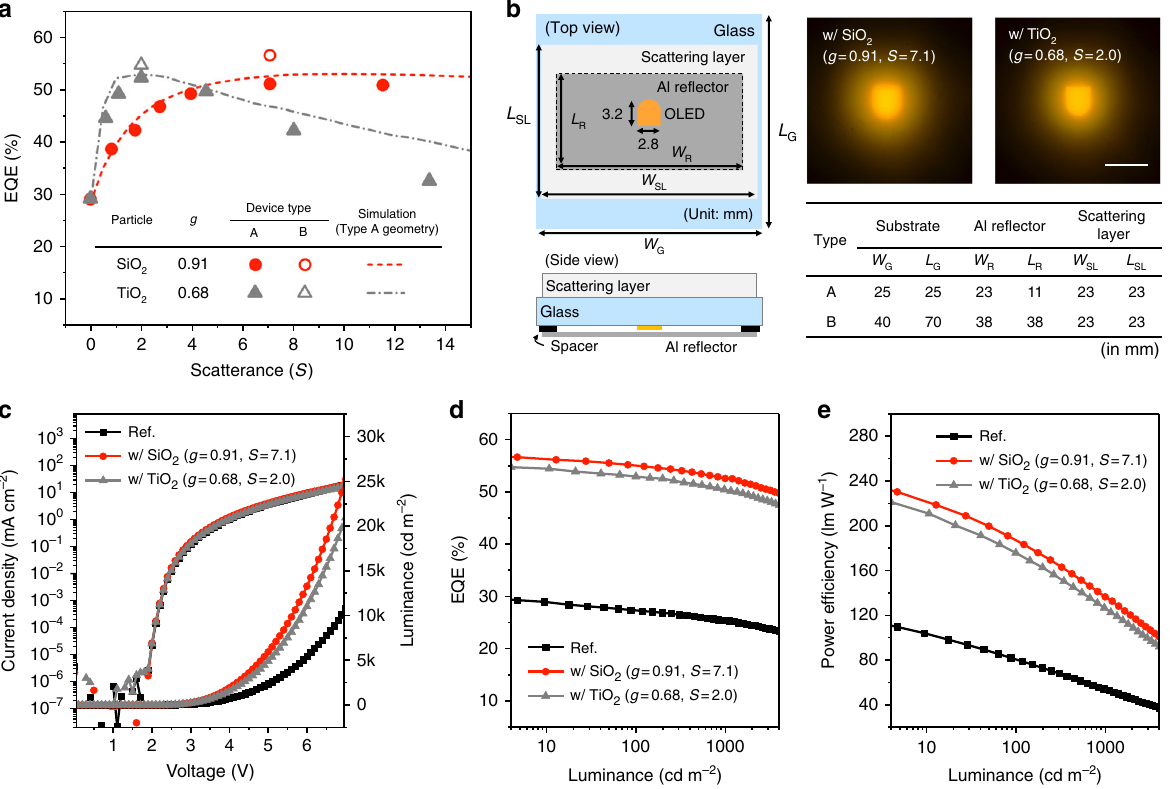
Fig. 4 The performance of organic light-emitting diodes (OLEDs) fabricated on large substrates. a The measured external quantum ef fi ciencies (EQEs) vs. scatterance ( S ) of OLEDs with SiO 2 -based (asymmetry parameter ( g ) = 0.91) and TiO 2 -based ( g = 0.68) scattering layers. The color-matched dotted lines indicate LightTools simulation results that re fl ect the actual geometry (Type A) used for EQE- S trend study. b Device test structures used to mimic a large- area device with a small, lab-scale active area. Type A uses a small substrate so that one can make several samples at the same time for studying the overall trend over certain variables. Type B uses a large substrate to explore the ultimate light extraction achievable via external scattering. Photographs of OLEDs (Type B) are also shown for both SiO 2 -based ( S = 7.1) and TiO 2 -based ( S = 2.0) OLEDs (scale bar: 5 mm). c − e Device characteristics of Type B